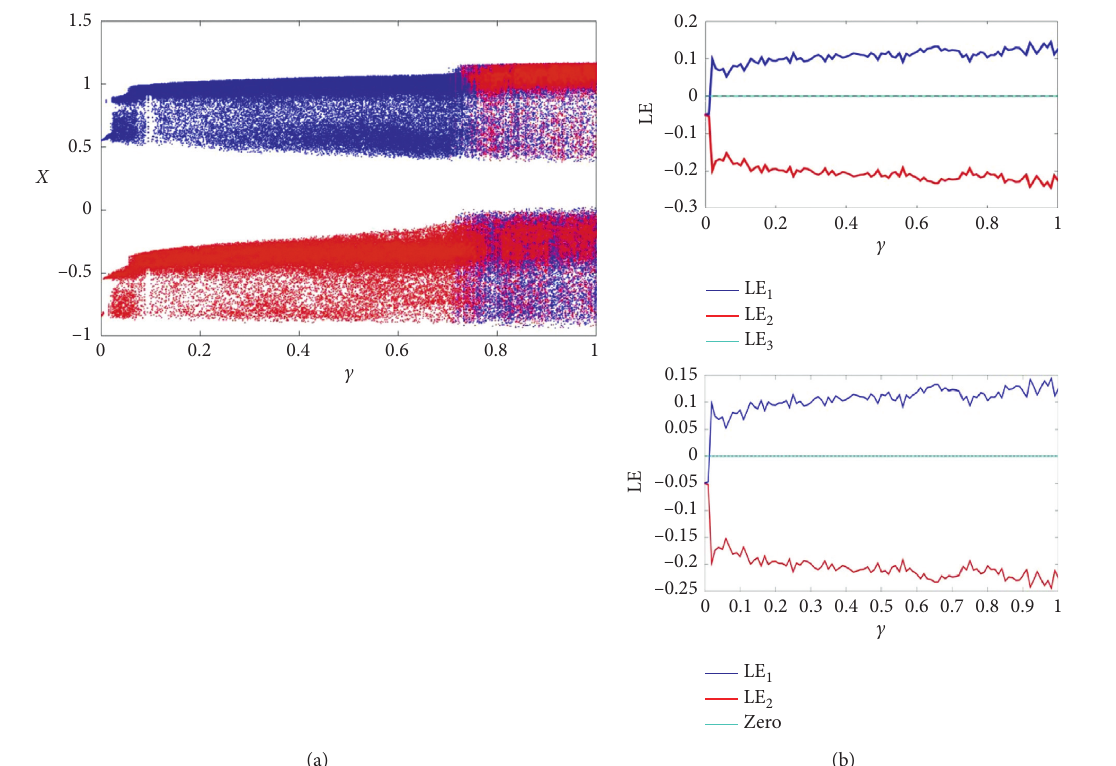
Figure 6: (a) Bistability of system (7) with the blue plots showing the forward continuation (increase parameter c from 0 to 1) and the red plots showing backward continuation (decrease parameter c from 1 to 0) with reinitialization of the initial conditions. (b) Corresponding Lyapunov